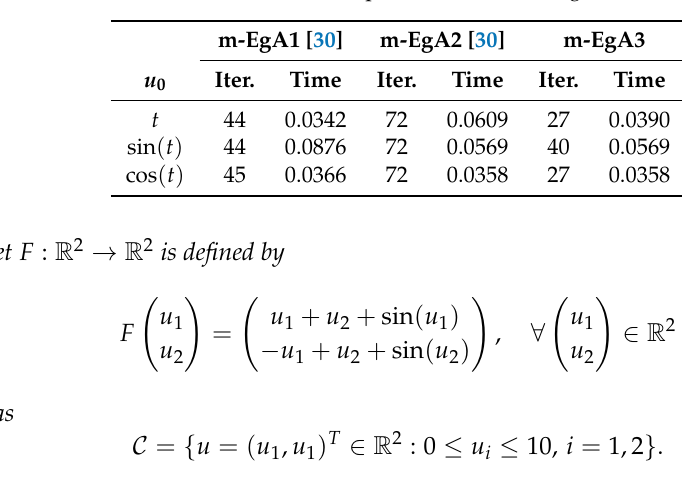
Figure 11. Numerical behaviour of Algorithm 1 compared to Algorithm 1 in [30] and Algorithm 2 in [30] for Example 1, when u 0 = cos ( t ) . Table 2. Numerical comparison values for Figures